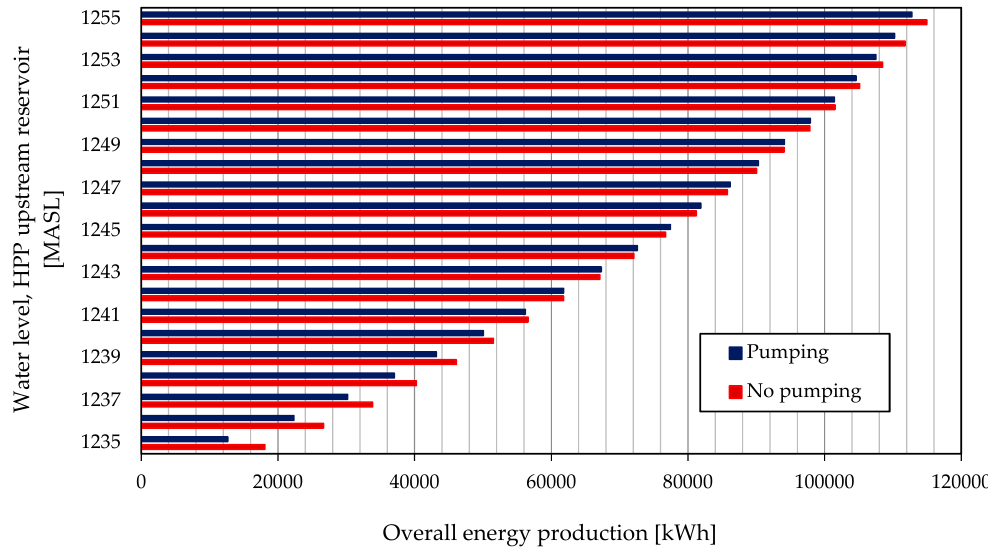
Figure 6. Overall energy production [kWh] obtained at different values of the initial water level in the HPP upstream reservoir (Oa ș a Lake).